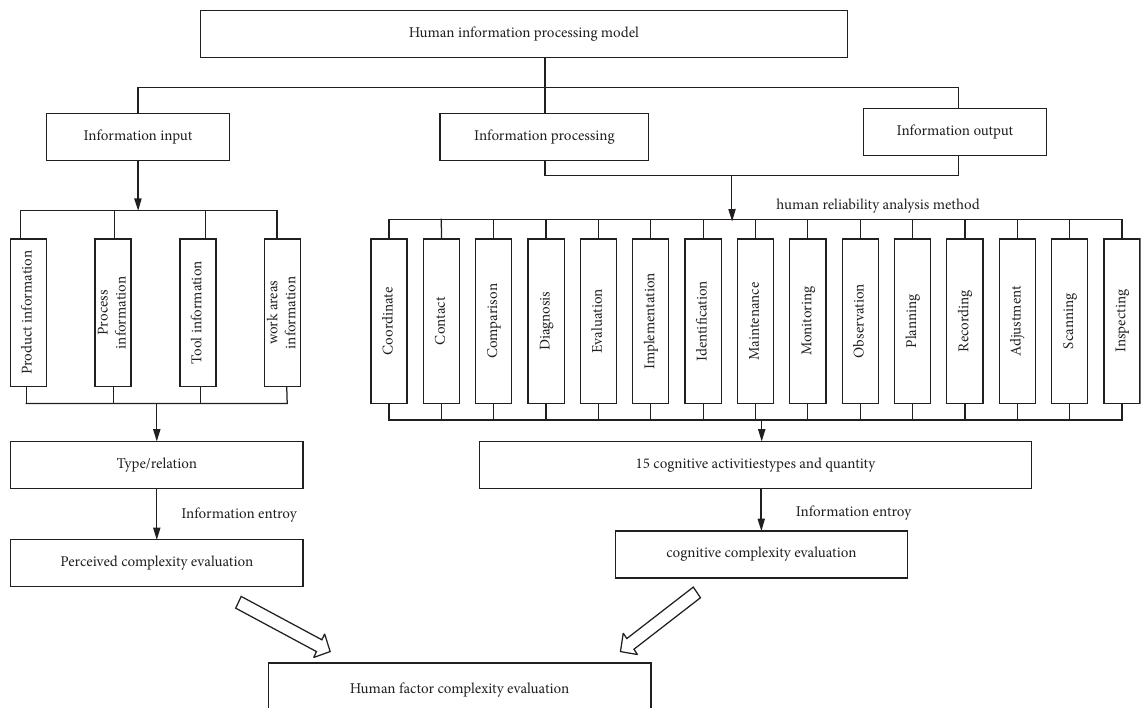
Figure 4: Flow chart of the human factor complexity